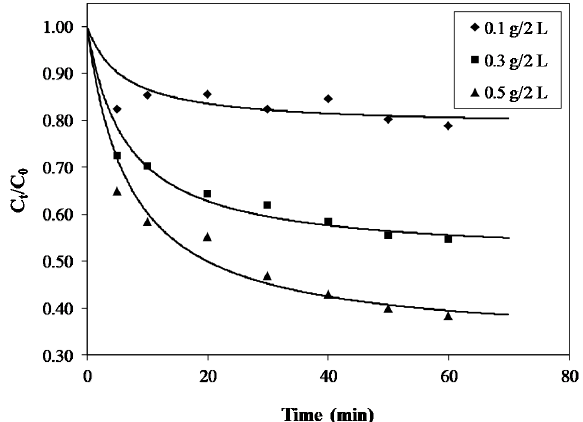
Figure 5. Plots of dimensionless concentration vs. time at different DM-BC dosages. Biosorption conditions: initial MB concentration of 10 mg/L, temperature of 25 °C, and agitation speed of 200 rpm. Symbols: C t = residual MB concentration at time t , C 0 = initial MB concentration. Full lines: calculated from Equation (1) and Table 3. Table 2. Kinetic parameters for methylene blue (MB) biosorption onto DM-BC at initial MB concentrations based on the pseudo-second-order model a .